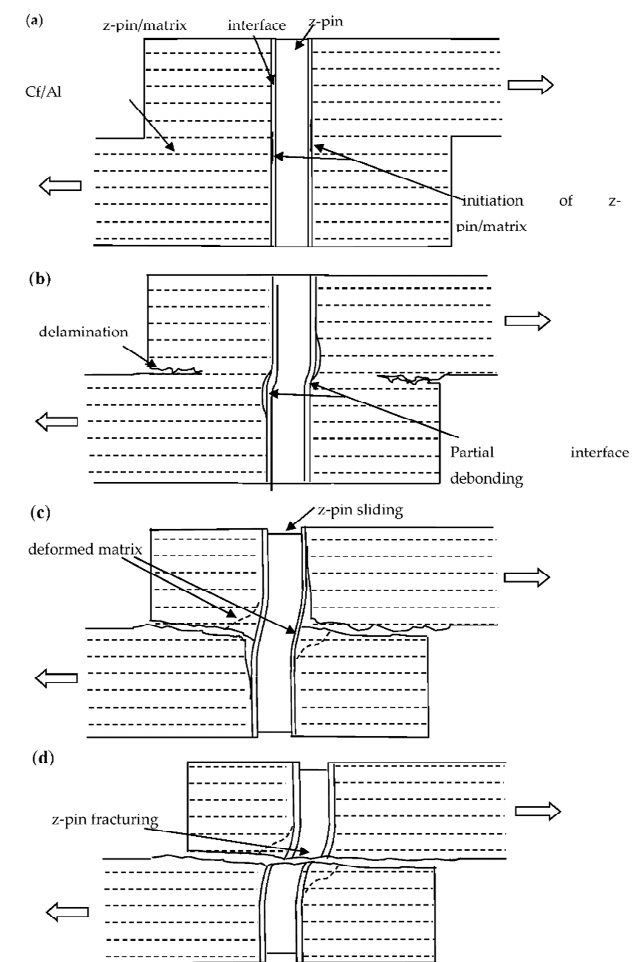
Figure 9. The schematic of the failure process of the z-pinned composites: ( a ) The z-pin / matrix interface crack initiated ( b ) the z-pin / matrix interface was partially debonded and delamination initiated ( c ) z-pin and matrix were deformed ( d ) the z-pin ruptured and the specimen